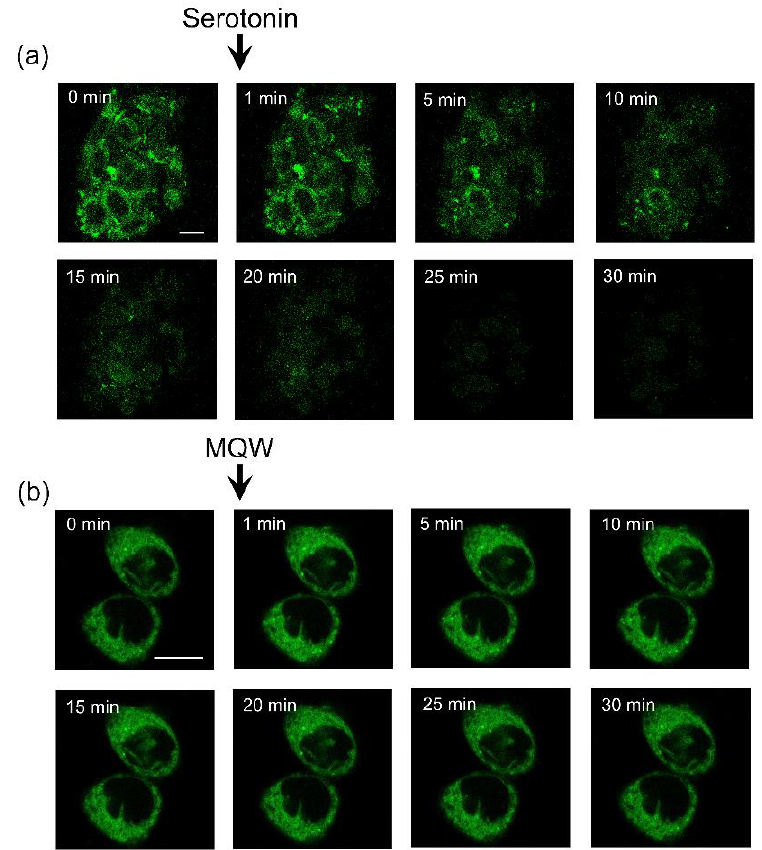
Figure 5. ( a ) Confocal microscopic images of the human serotonin 1A receptor stably expressed in CHO-K1 cells labeled with the NBD-labeled analog of serotonin (I) and chased with unlabeled serotonin. Images represent mid-plane confocal sections of the same group of cells before and after addition of serotonin. Cells were initially labeled with 7 µ M of analog I in HEPES-HANKS buffer, pH 7.2 and subsequently serotonin (final concentration 7 mM) was added at 1 min time point (indicated by an arrow) from a concentrated aqueous stock solution. ( b ) Control experiment showing confocal microscopic images of the serotonin 1A receptor stably expressed in CHO-K1 cells labeled with the NBD-labeled analog of serotonin (I) and chased with same volume of Milli-Q water (MQW) as in panel ( a ). Images represent mid-plane confocal sections of the same group of cells before and after addition of MQW. Scale bars represent 10 µ m. See Materials and Methods for other